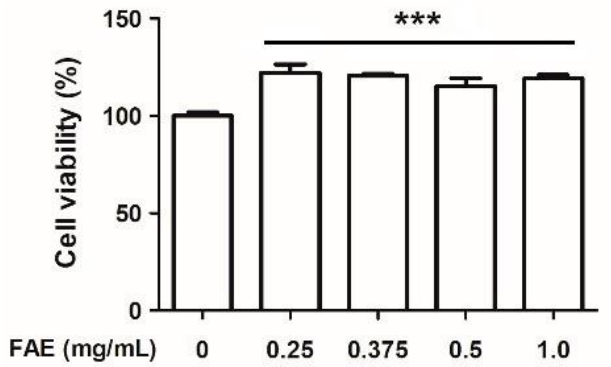
Figure 1. The cytotoxic activity of Ficus awkeotsang Makino extract (FAE) in Hs68 cells for 24 h. Significant differences between control (0 mg/mL FAE) and other treatments were determined using Turkey HSD test. *** p < 0.001; n = 3; all error bars represent the standard deviation of the mean.